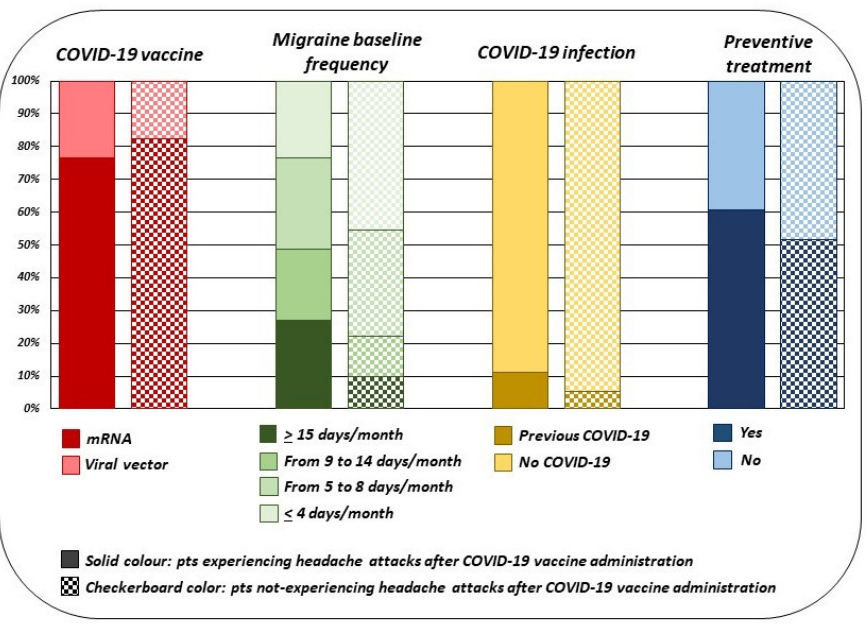
Figure 2. Clinical differences between migraine patients with and without headache attacks after the first COVID-19 vaccine administration.